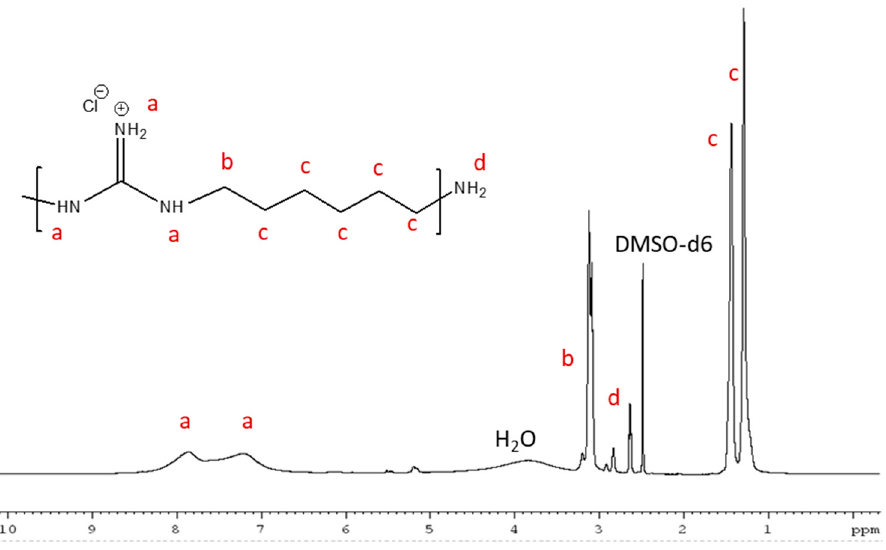
Figure 1. 1 H ‐ NMR spectrum of PHMG oligomer in DMSO ‐ d6 deuterated